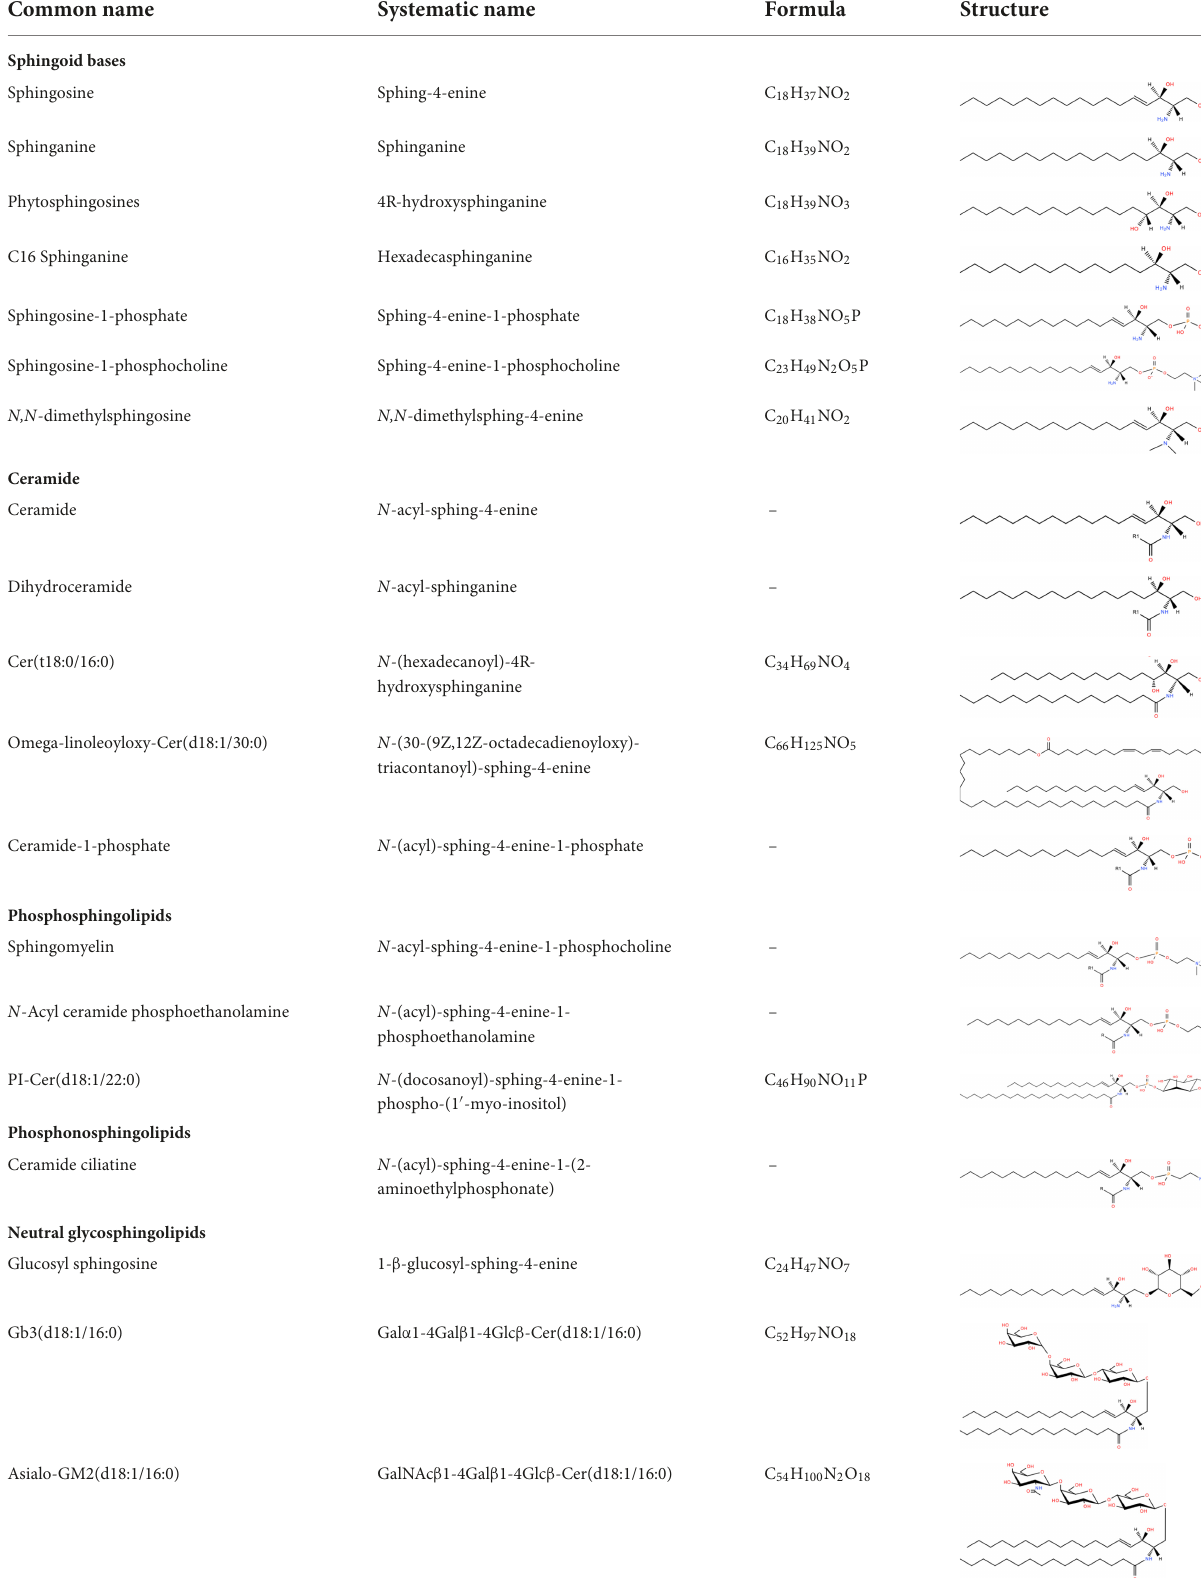
TABLE 1 Classification and representative structures for